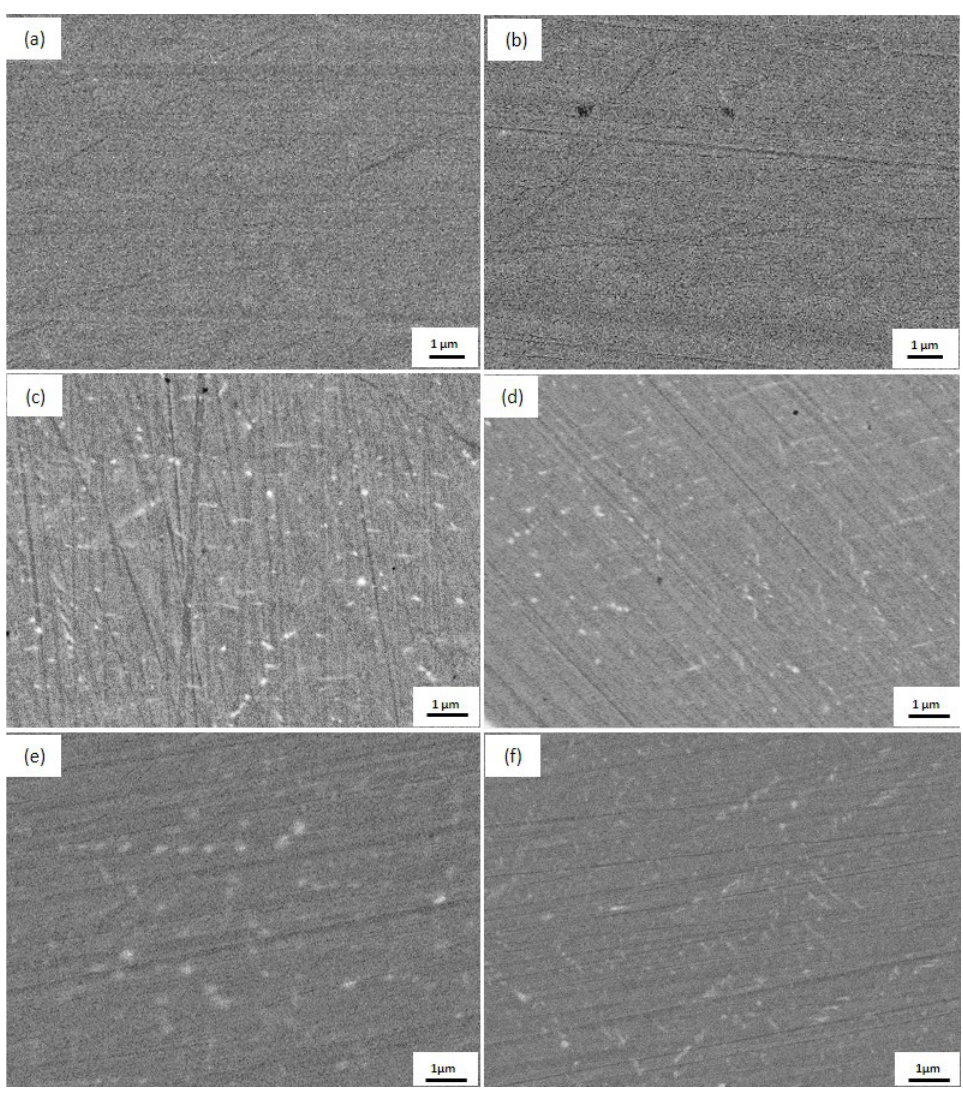
Figure 3. Microstructure of continuous Ag precipitates in the Cu matrix of solution-aged samples at various temperatures for 4 h. Fe-free alloy: ( a ) as-solid-solution, ( c ) 450 °C, ( e ) 500 °C, and Fe-doping alloy: ( b ) as-solid-solution, ( d ) 450 °C, and ( f ) 500 °C.